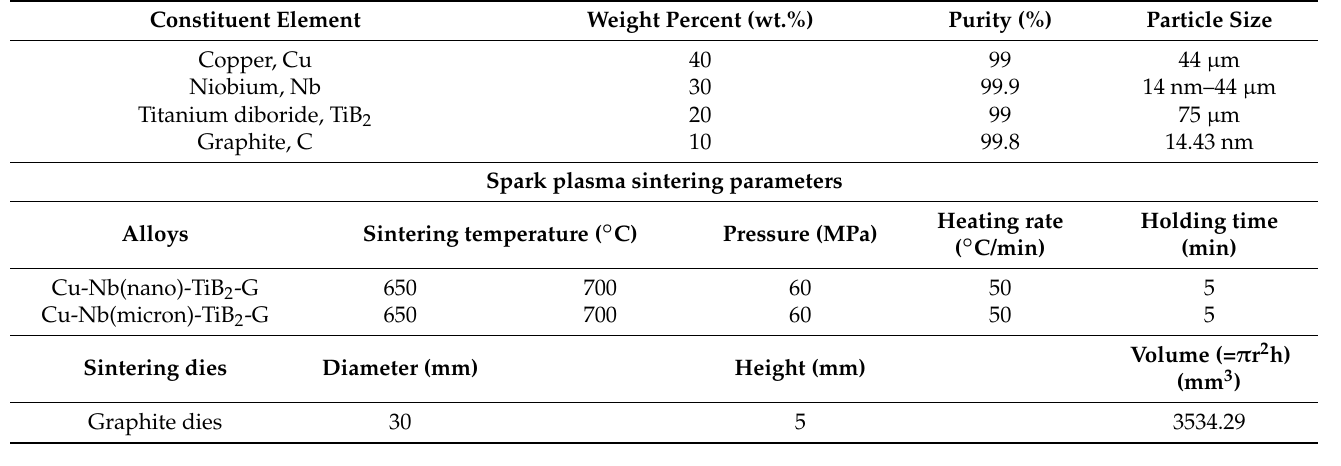
Table 1. Chemical composition of the multi-principal alloy and Spark Plasma Sintering parameters with sintering